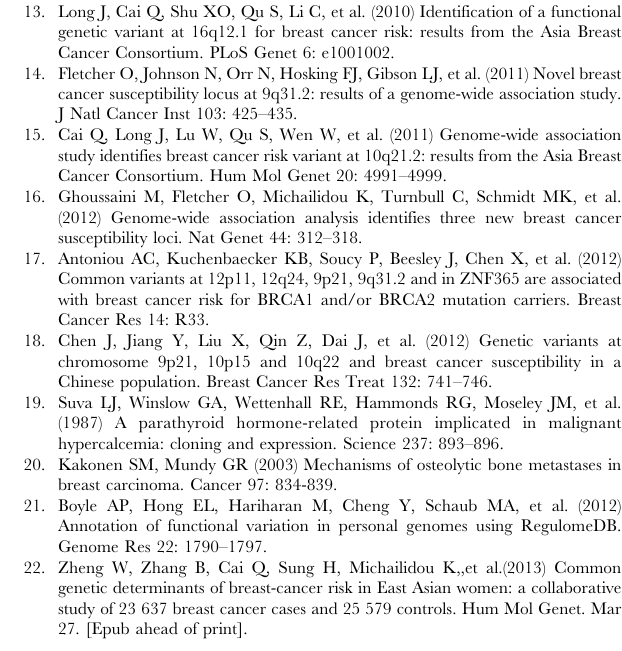
Table S1 SNPs in strong LD (r 2 . 0.8) with rs10771399 at 12p11 based on 1000 Genome pilot CHB/JPT data and biological function scores predicted by RegulomeDB. (DOC) Table S2 SNPs in strong LD (r2 . 0.8) with rs1292011 at 12q24 based on 1000 Genome pilot CHB/JPT data and biological function scores predicted by